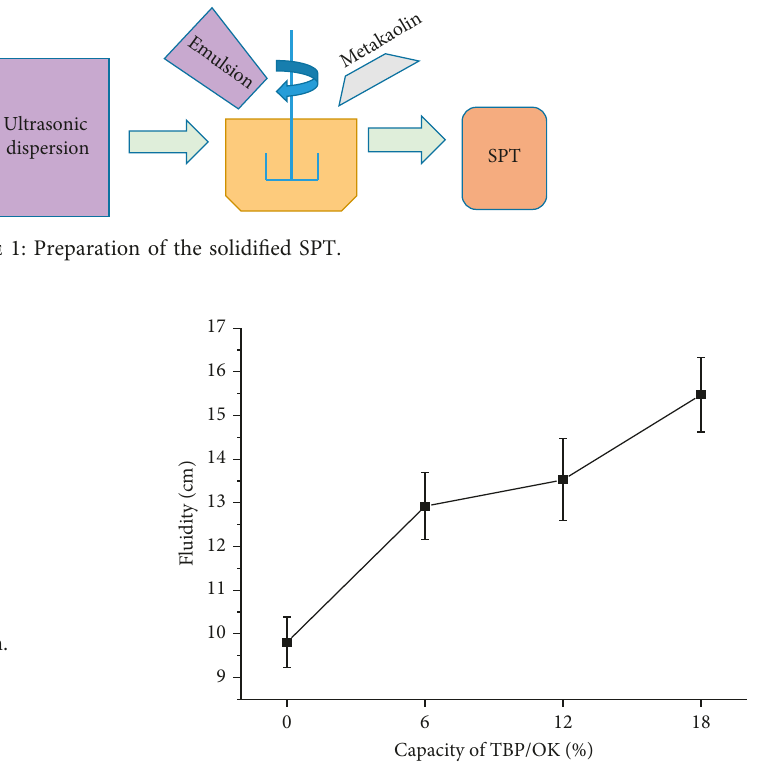
Figure 5: Fluidity of the solidified SPTsamples with different TBP/ OK